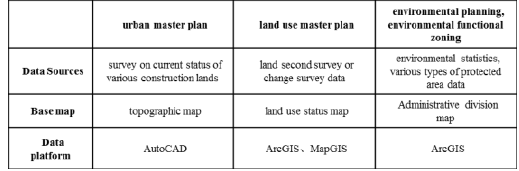
Table 2. Comparision of platform information